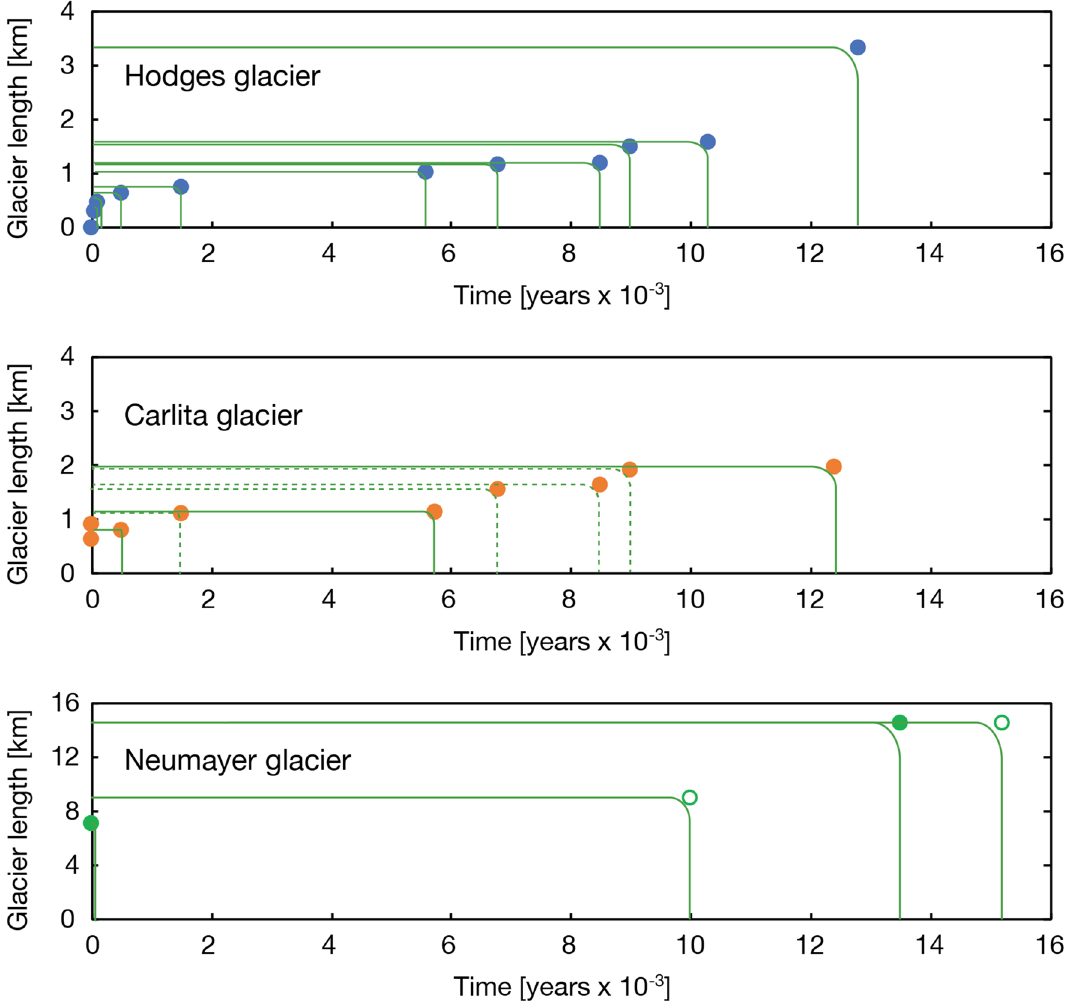
Figure 7. Exposure dating of glacier extents (marked by dots in the three panels representing mean age with reference to Table S1) for the three examined glaciers in South Georgia: Hodges Glacier, Carlita Glacier and Neumayer Glacier. Additional constraints on the extent of Neumayer Glacier are provided by a recently radiocarbon-dated lake sedimentary archive in the lower part of Olsen Valley 22 , denoted by an open circle at ca. 10 ka. Moreover, Graham et al. 11 provide a limit for the horizontal extension of Neumayer Glacier during the Antarctic cold reversal (ACR) at ca 15.5 ka. Dotted lines in the upper panel are reconstructed glacier advances based on bog and lake sediments from Carlita Bay (Fig. 6) 15